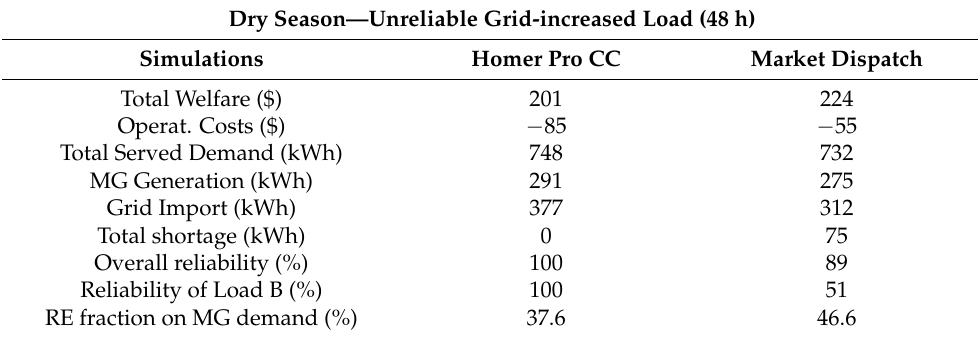
Figure 18. Market-based optimal dispatch for dry season unreliable grid. Table 5. Comparison Table for Simulation Results under Rainy Season with an unreliable main